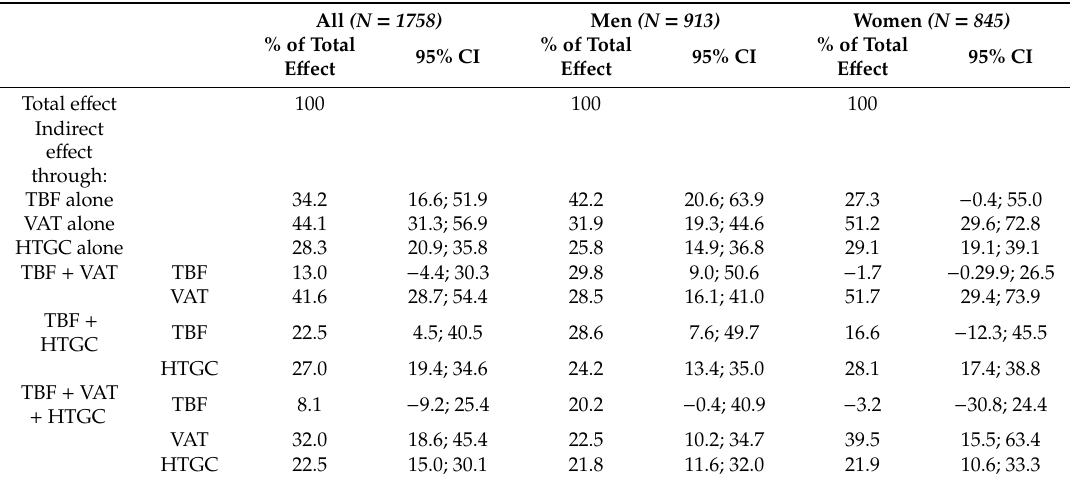
Table 3. Analysis of indirect e ff ects of the mediators total body fat, visceral adipose tissue and hepatic triglyceride content in the association between adult weight gain and